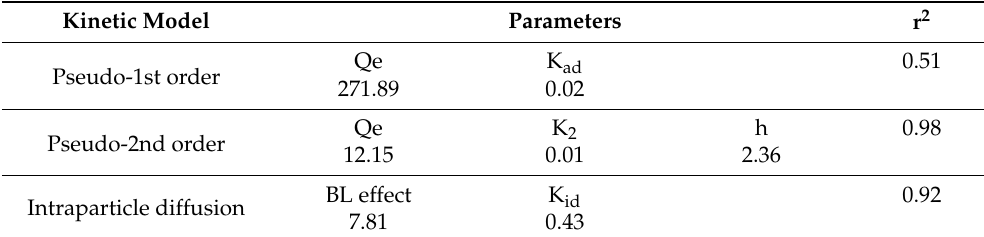
Table 5. Kinetic parameters values determined by fitting the experimental data of Cr(VI) removal under dynamic conditions for